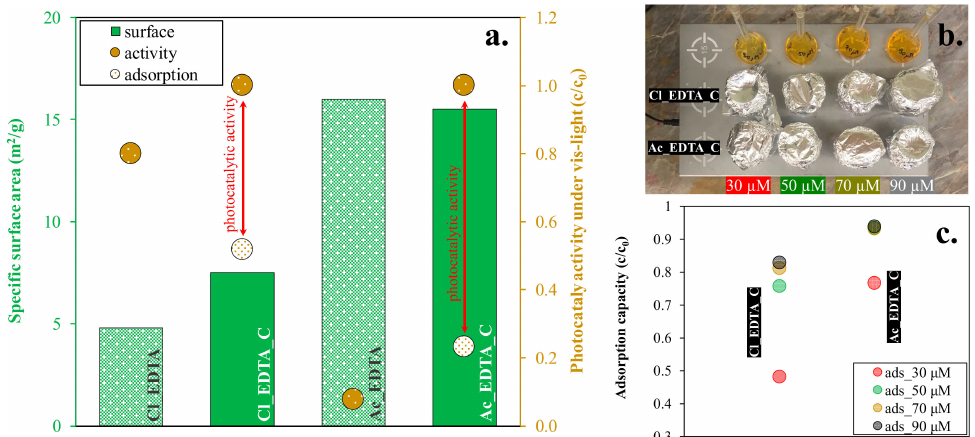
Figure 8. ( a ) The specific surface area (before and after the calcination step), the photocatalytic activity, and the measured adsorption results at 30 µ M with the samples with the highest conversion value; ( b ) the adsorption capacity on four di ff erent concentration (30, 50, 70, and 90 µ M), and ( c ) the measurement in the dark with constant